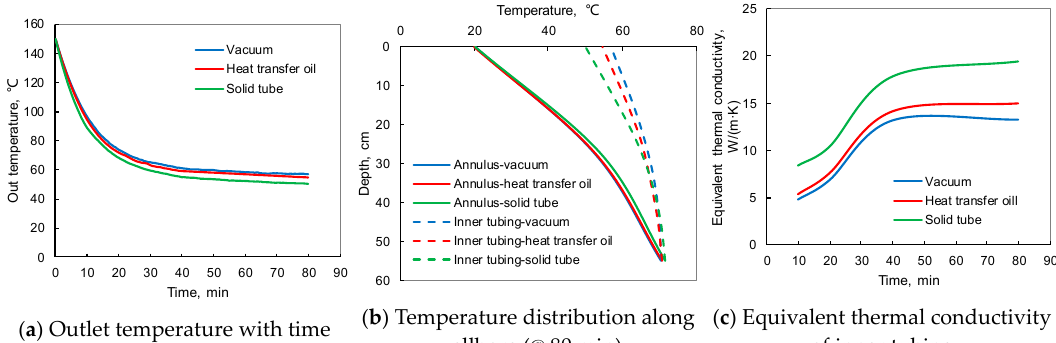
Figure 17. Temperatures at the outlet and along the wellbore at different thermal conductivities of inner tubing.